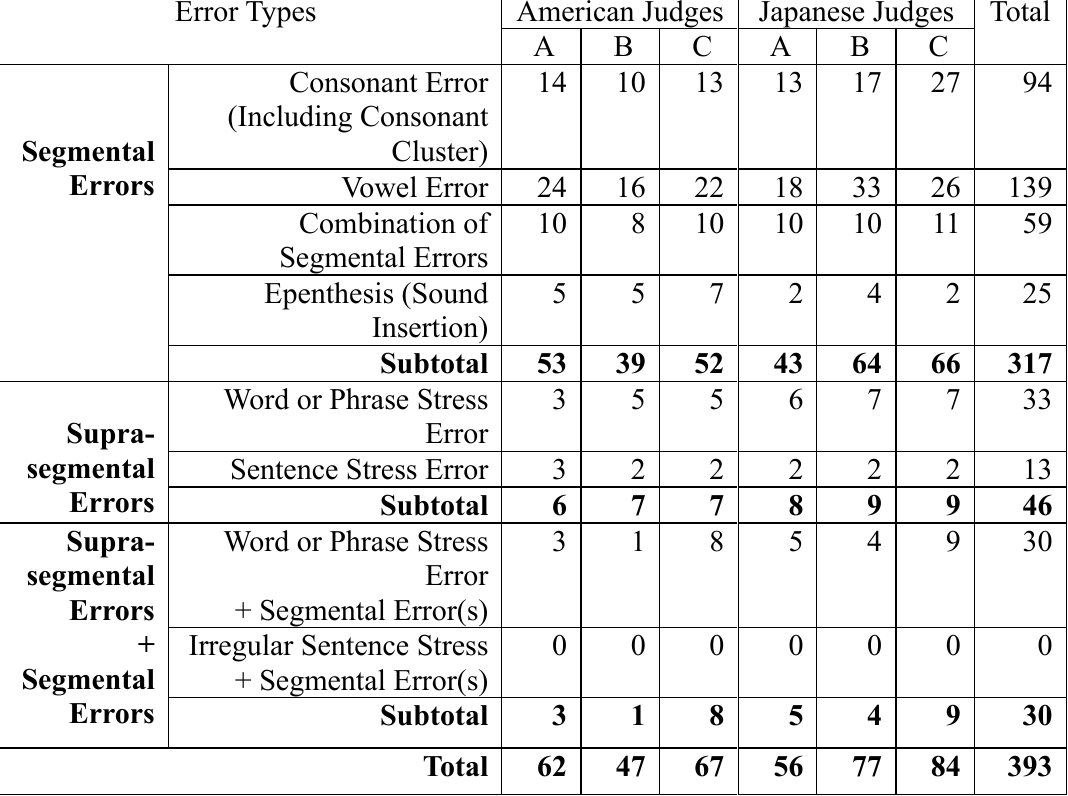
Identified Causes of Misunderstandings by Error Types